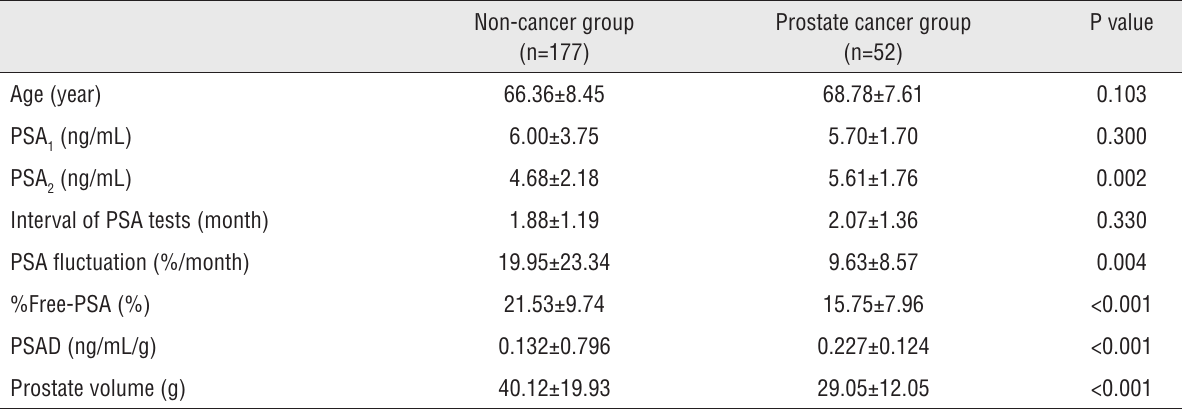
Table 2 - Comparison between non-cancer and prostate cancer